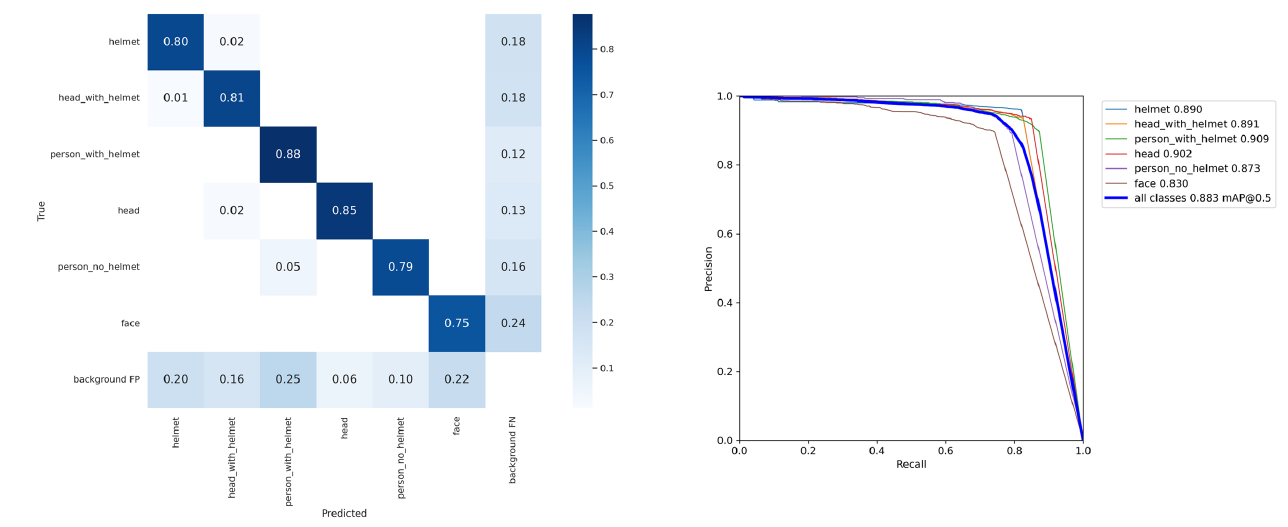
Figure 8. Confusion matrix and PR curve of the object detection model calculated on the SHEL5K dataset and the YOLOv5x [13] model.